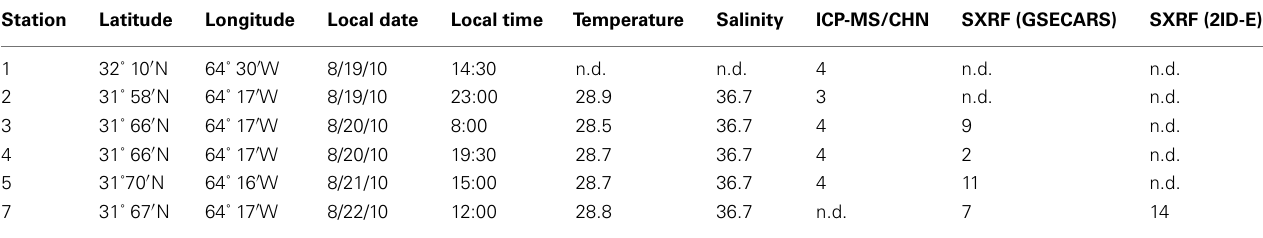
The number of replicate samples analyzed is listed for each technique. For inductively coupled plasma mass spectrometry (ICP-MS) and CHN analysis the number of replicate bulk colony assemblages analyzed is shown. For synchrotron x-ray fluorescence (SXRF) the number of trichome sections analyzed is shown. GSECARS and 2ID-E indicate the beamlines used to conduct SXRF analyses at the Advanced Photon